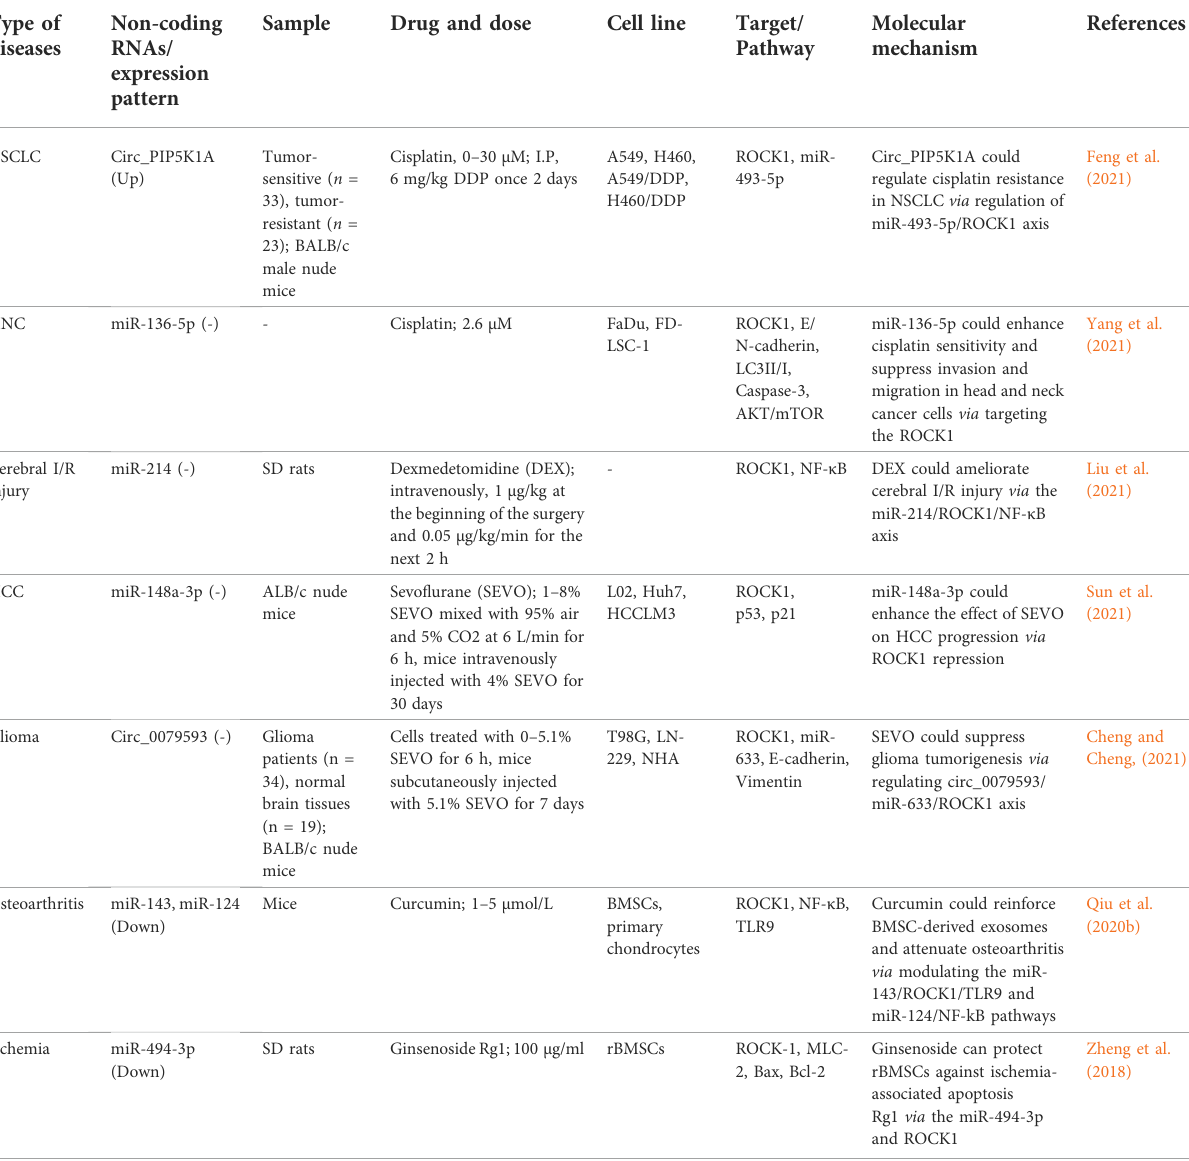
TABLE 7 Drug and ROCK1-interacting non-coding RNAs (NSCLC: Non-small cell lung cancer, HNC: Head and neck cancer, Cerebral I/R injury: cerebral ischemia/reperfusion injury, HCC: hepatocellular